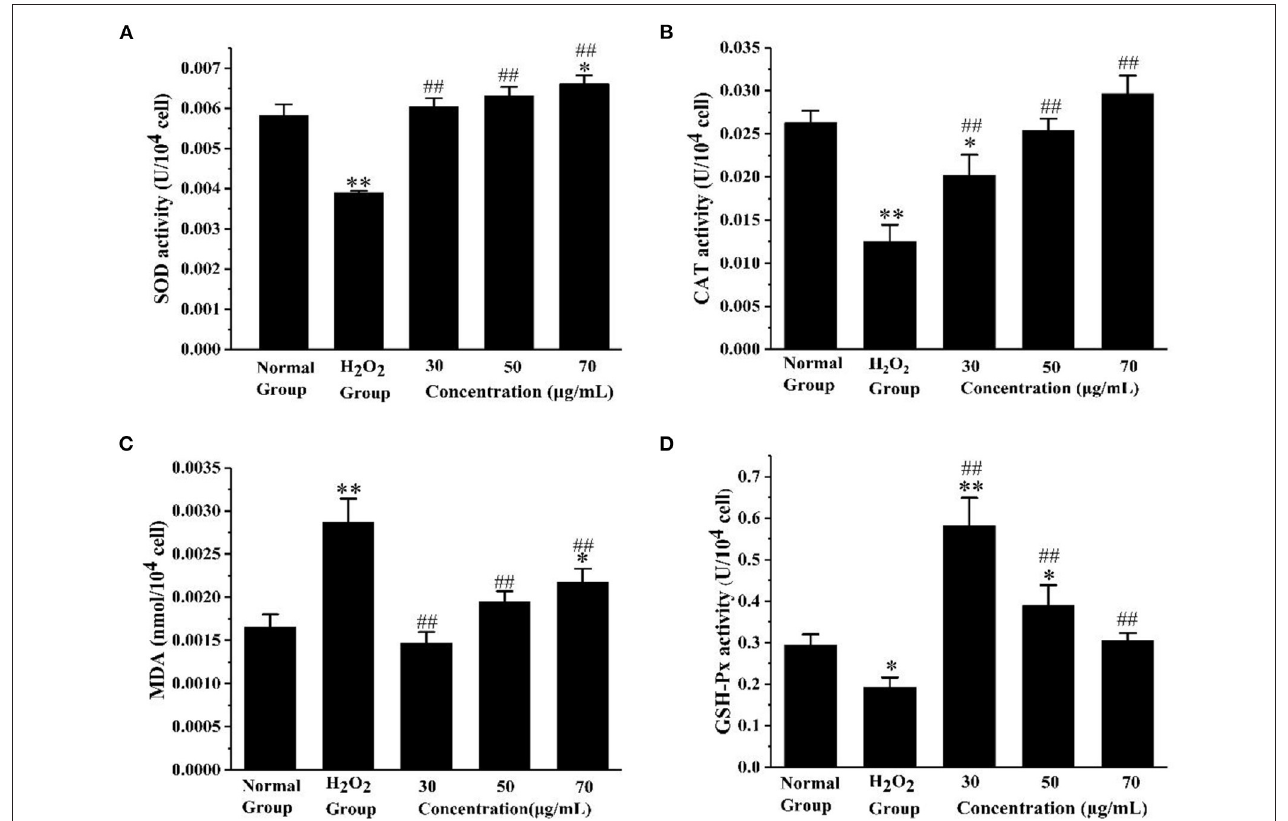
FIGURE 5 | Evaluation of antioxidant enzyme activity and lipid peroxidation. (A) The effect of AS on the activity of SOD. (B) The effect of AS on the activity of CAT. (C) The effect of AS on the cellular concentration of MDA. (D) The effect of AS on the activity of GSH-Px. The results were expressed as the mean ± SE of three independent experiments. * P < 0.05 compared with the normal cell group, ** P < 0.01 compared with the normal cell group. ## P < 0.01 compared with H 2 O 2 , ANOVA analyses ( Supplementary Table 5